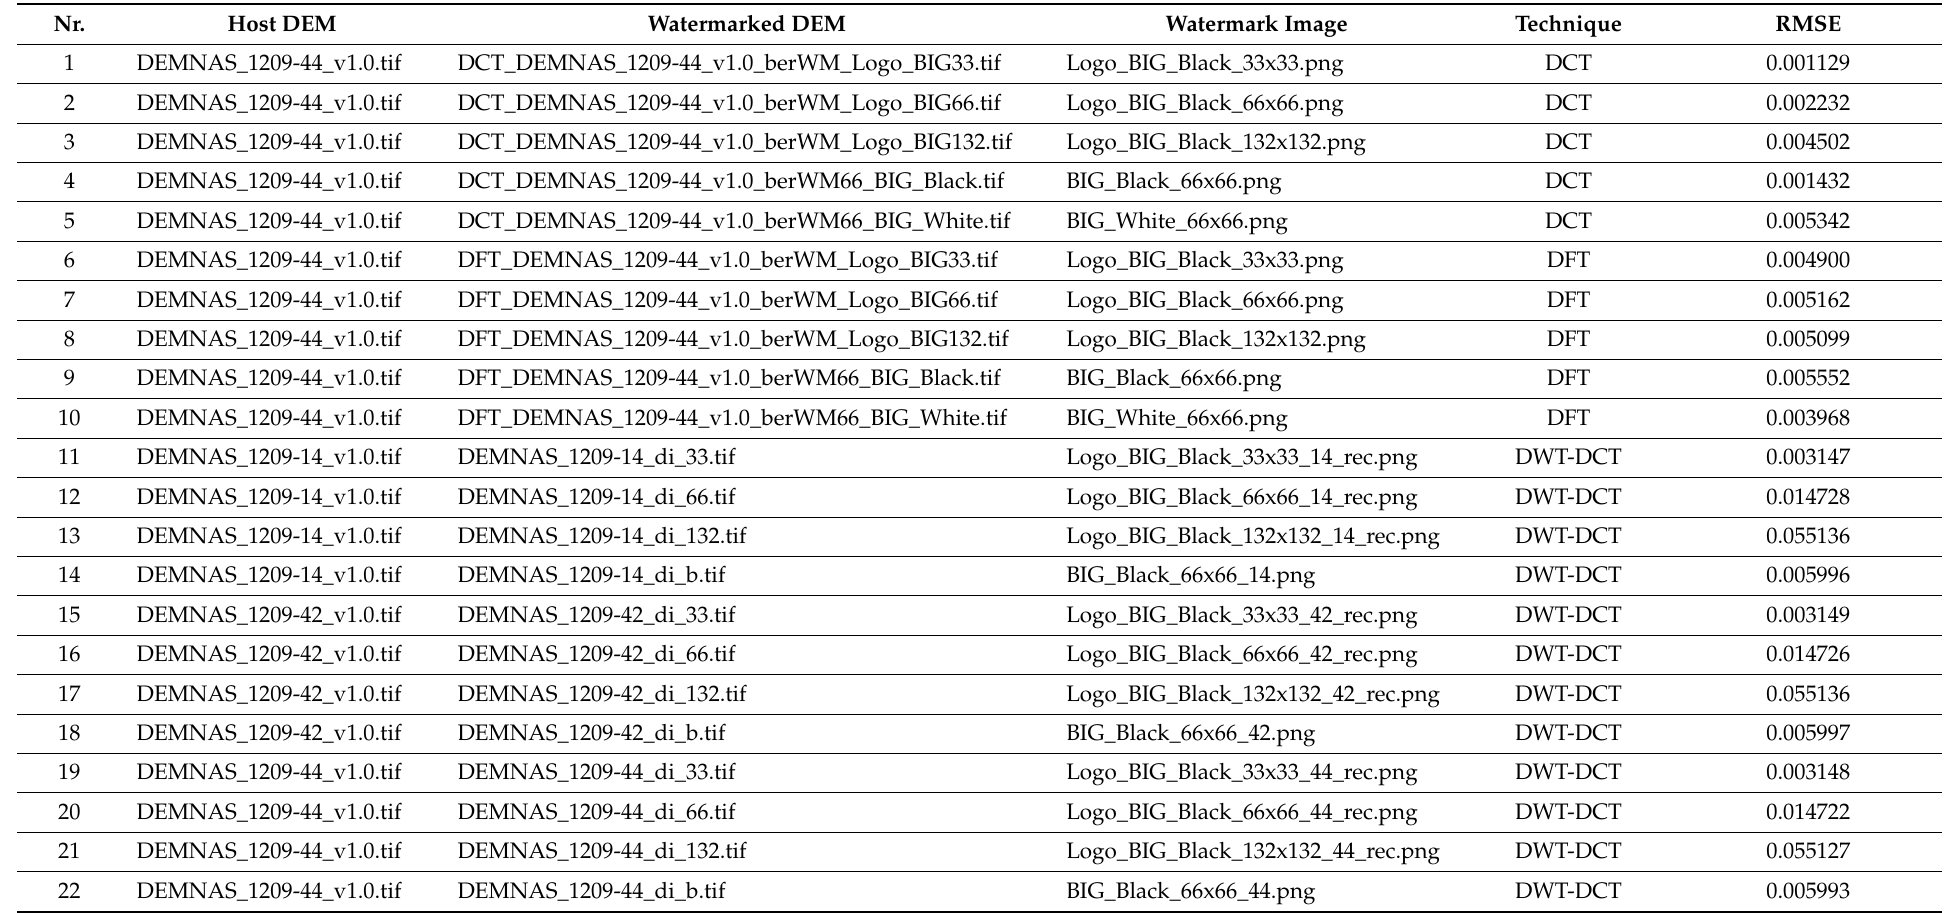
Table 10. Experimental results of the evaluation parameter of